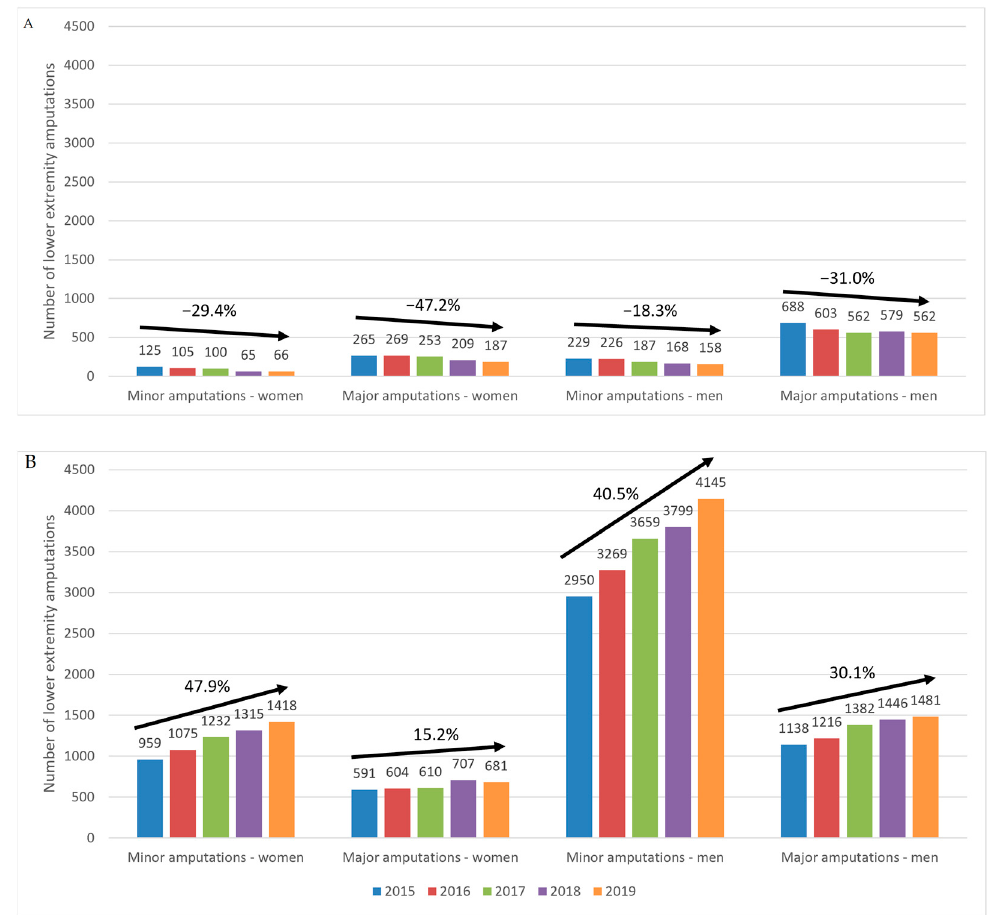
Figure 4. Trends in the number of lower extremity amputations in patients with T1DM ( A ) and T2DM ( B ) according to sex and level of amputation. T1DM, type 1 diabetes mellitus; T2DM, type 2 diabetes mellitus.